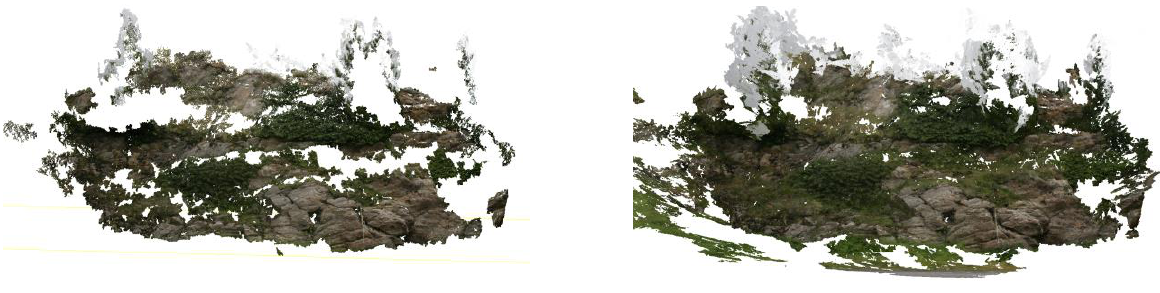
Figure 27. Comparison of two point clouds from Pix4D and Canon5D with recommended settings (left) and highest settings